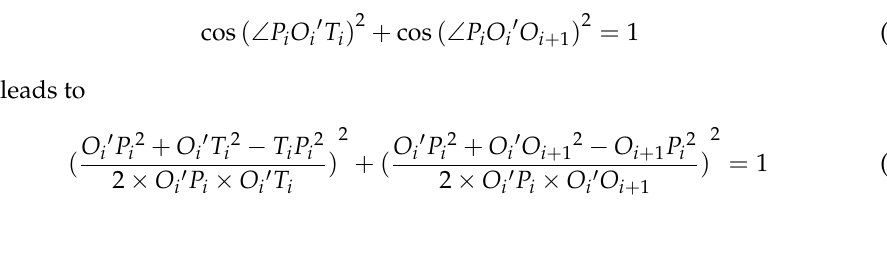
Figure 3. Schematic diagram of route planning when the distance D O turning radius R . ( a ) is the schematic diagram of route planning at ∠ O i P i P i + 1 ≤ 90, ( b ) is the schematic diagram of a route planning at ∠ O i P i P i + 1 > 90, the red line is the calculated shortest